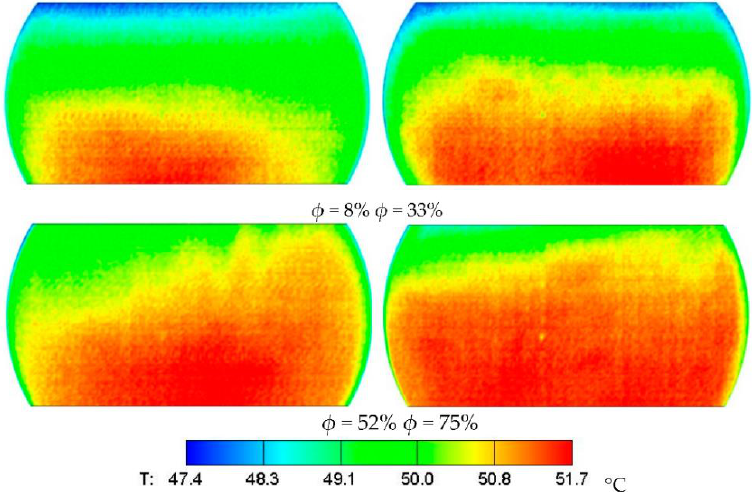
Figure 8. Infrared thermal images of the vapor chamber at different filling rates ( q = 17.7 W/cm 2 , H = 20 mm).